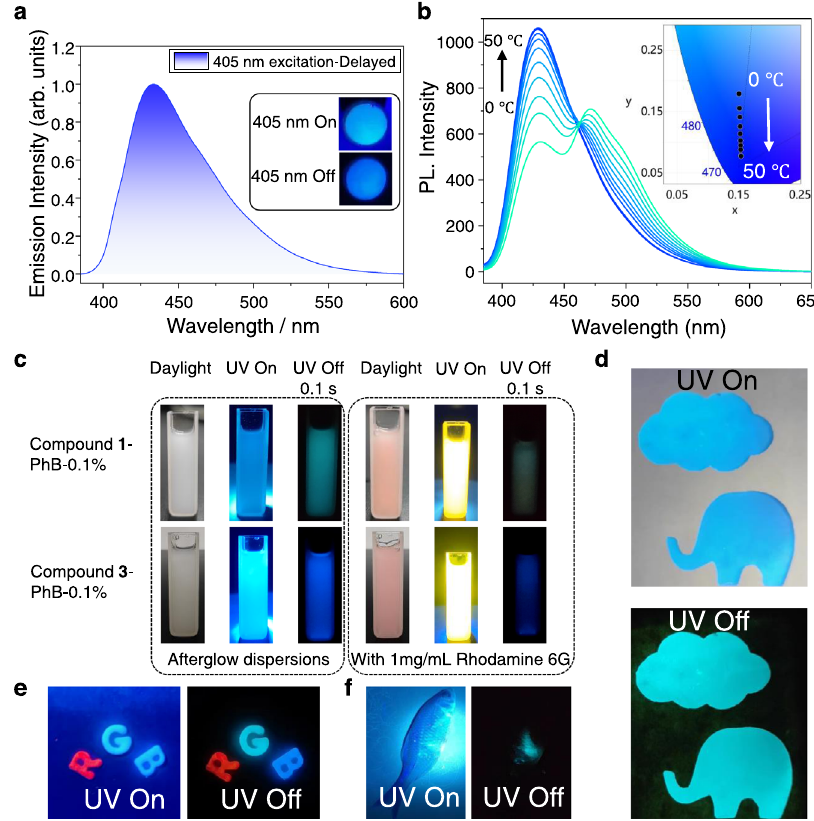
Fig. 5 | Functionalities of the up-converted RTP materials. a Delayed emission spectra(1msdelay)of 3 -PhB-0.1%powderexcitedby405nmatroomtemperature. Inset: photographs of the 3 -PhB-0.1% powder, recorded upon switching on (top) and off (bottom) a 405nm laser; b Temperature-dependent delayed emission spectra (1ms delay) of 3 -PhB-0.1% powder from 0 to 50°C and CIE diagram; c Aqueous afterglow dispersion of BPBF 2 -PhB-0.1% stabilized by Pluronic